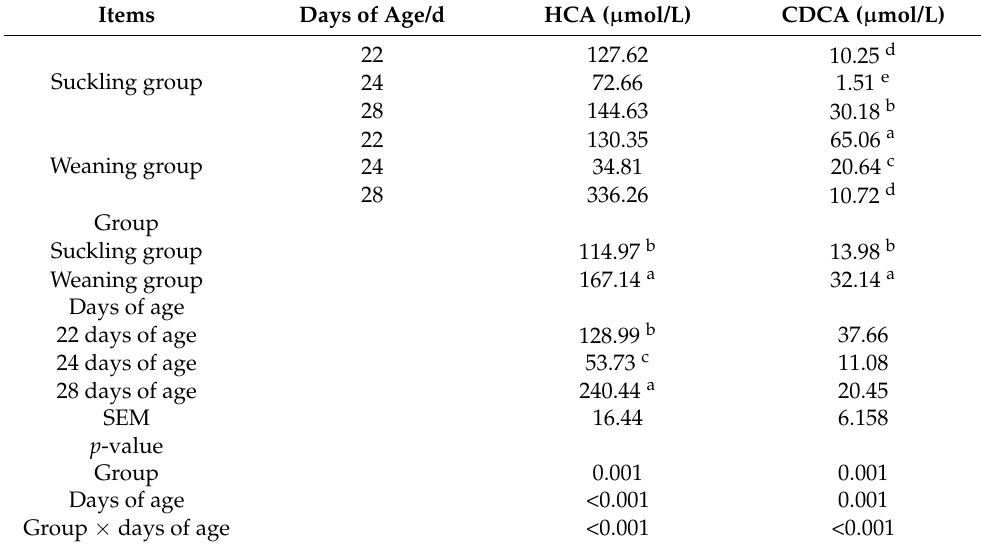
Table 2. Effects of weaning at 21 days of age on primer BAs of cecum